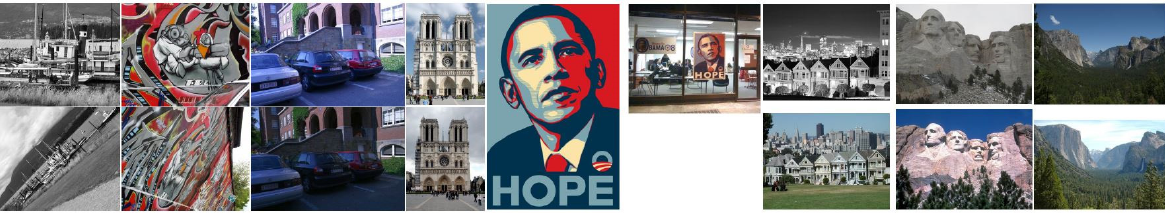
Figure 5. Image pairs from the EdgeFoci dataset.